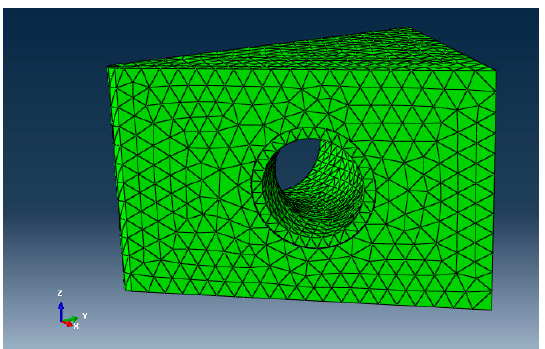
Figure 18. Structural model of the elbow buried in the soil.